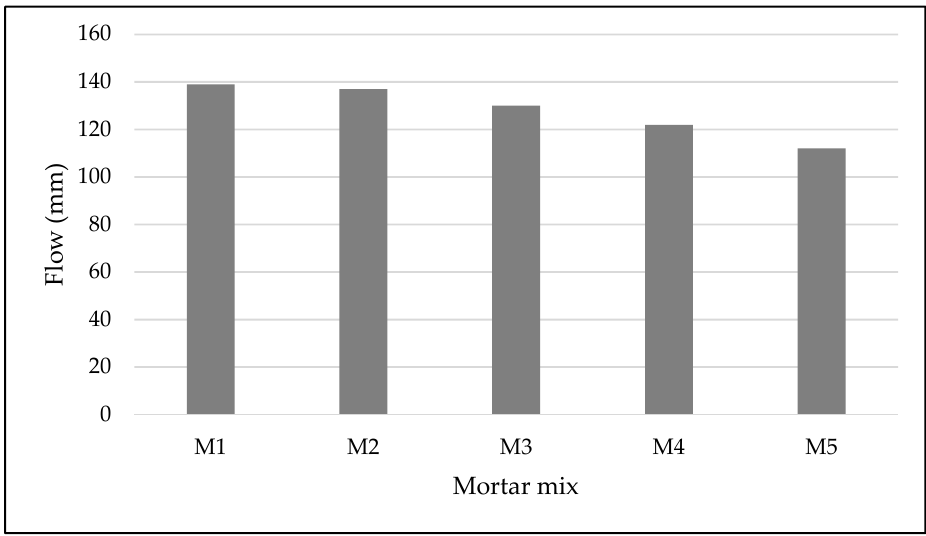
Figure 2. Flow table test results of mortar mixes.